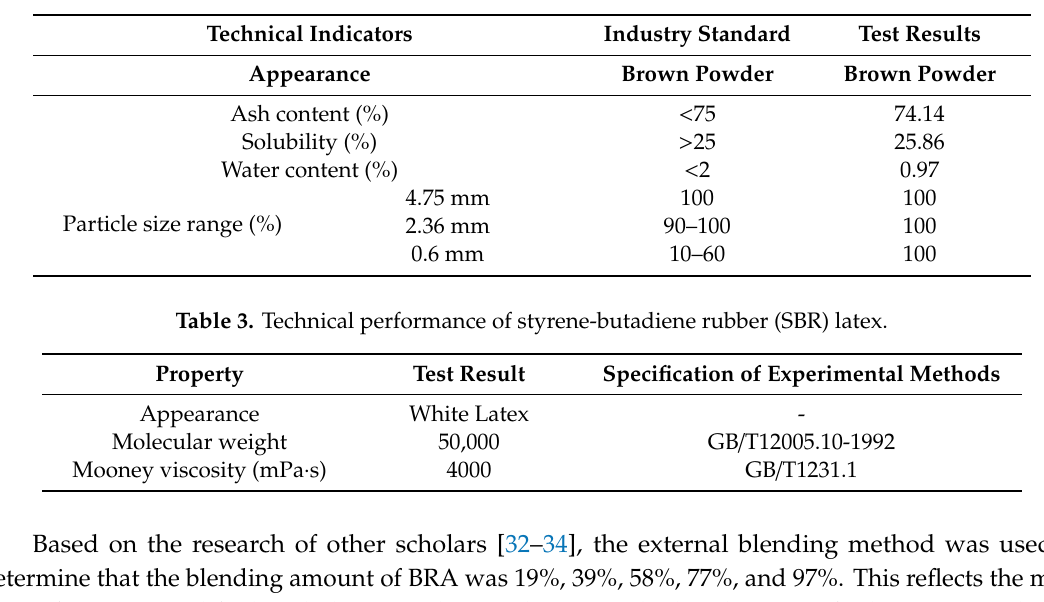
Table 3. Technical performance of styrene-butadiene rubber (SBR) latex.